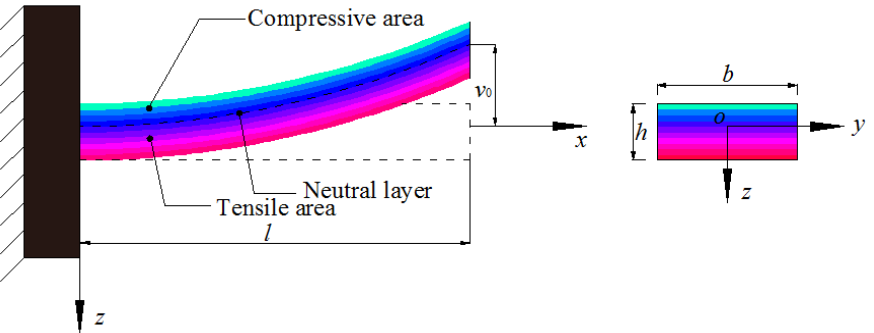
Figure 2. Scheme of the functionally-graded piezoelectric materials (FGPM) bimodular cantilever beam.